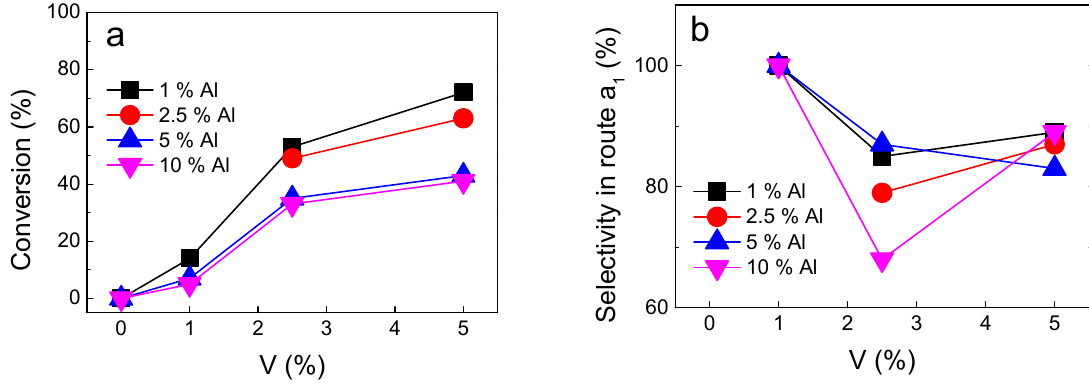
Figure 4. Loading effect of aluminum oxide anchors and anchored vanadium ions on conversion ( a ) and selectivity to route a 1 ( b ) for VAl-MS-L-cal catalysts.